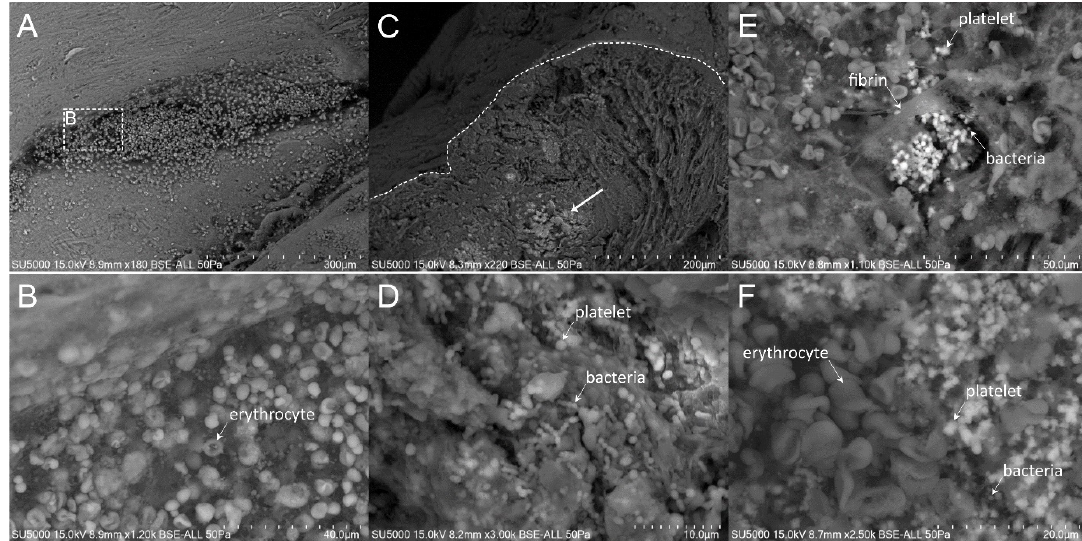
Figure 5. Scanning electron microscopy of S. gallolyticus -infected vegetation. ( A ) Low magnification of the surface of the vegetation. ( B ) Zoom-in on the boxed region in ( A ), with erythrocytes more or less visible in an amorphous cloth. ( C ) Surface and depth of the vegetation, which presented a layered organization at its periphery and an internal bright region (arrow). ( D ) High magnification on the bright region in ( C ) showing platelets and bacteria cocci chains. ( E ) High magnification showing platelets and bacteria next to a bundle of fibrin. ( F ) Damaged erythrocytes, platelets and bacteria. The vegetation is rich in platelets but with a sparse fibrinous network. Most of the cells were found embedded in an amorphous cloth.